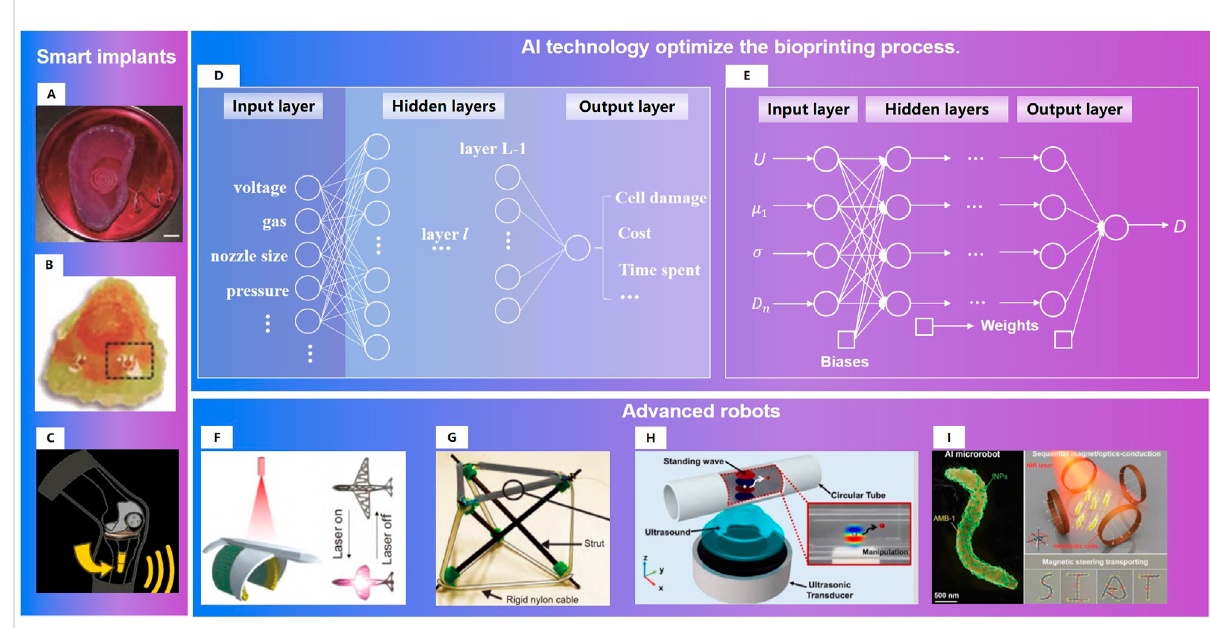
FIGURE 14 Research directions for satis fi ed repair of musculoskeletal injuries: 1) Smart implants. (A) A bionic ear (Mannoor et al., 2013). (B) . An odor- perceptive nose-like hybrid (Jodat et al., 2020). (C) . Smart prosthesis (Zimmerbiomet, 2021) 2)AI technology optimize the bioprinting process. (D) . Example neural network for process optimization in three-dimensional bioprinting (Ruberu et al., 2021). (E) . FCNNs for multi-objective optimization of drop-on-demand (DOD) bioprinting (Shi et al., 2019). 3)Advanced robots. (F) . Tissue engineering robot with light activated deformable wing (Xu et al., 2019b). (G) . Variable-stiffness tensegrity structures (Zappetti et al., 2020). (H) . An ultrasound-controlled actuator for targeted drug delivery (Lee et al., 2020). (I) . Acoustic powering and magnetic steering for actuating and navigating microrobots (Aghakhani et al.,